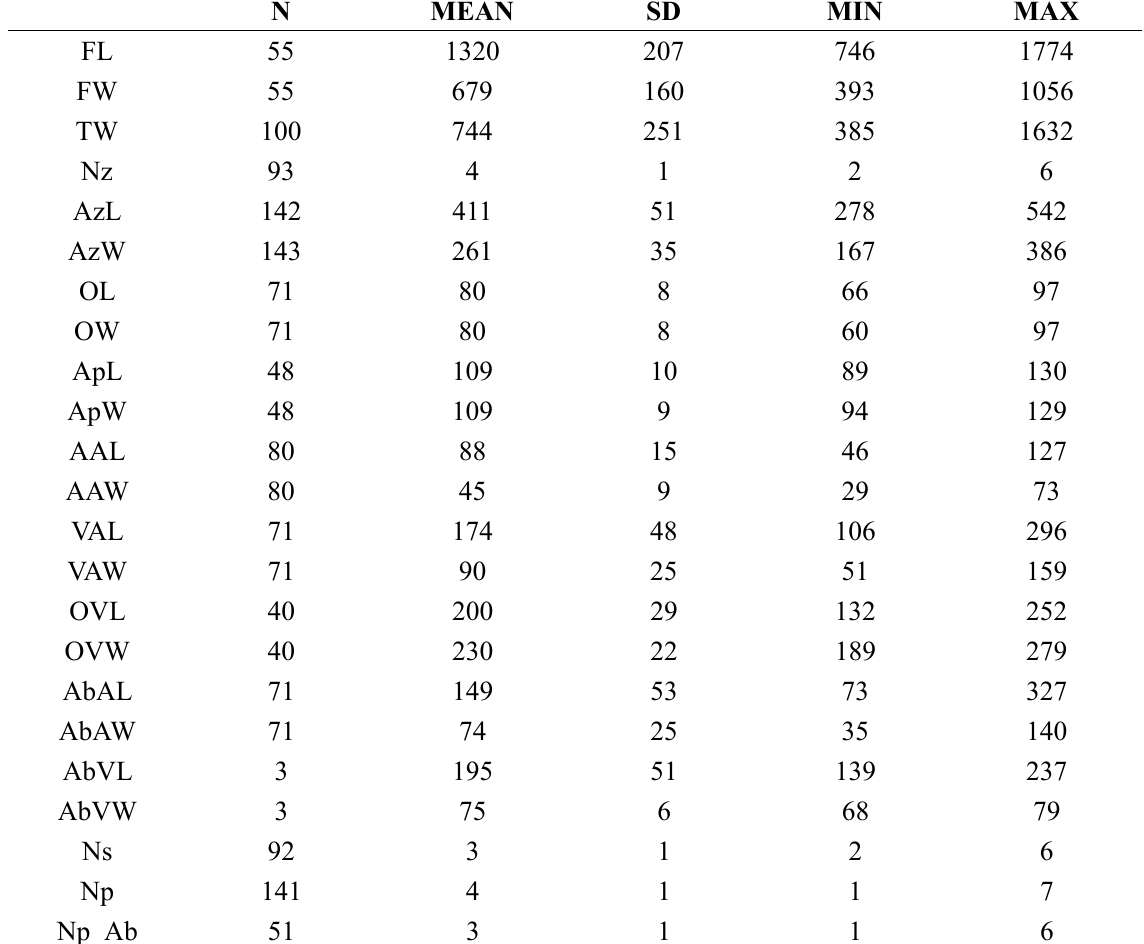
Table 3. Measurements of Schizoretepora aviculifera (Canu & Bassler,